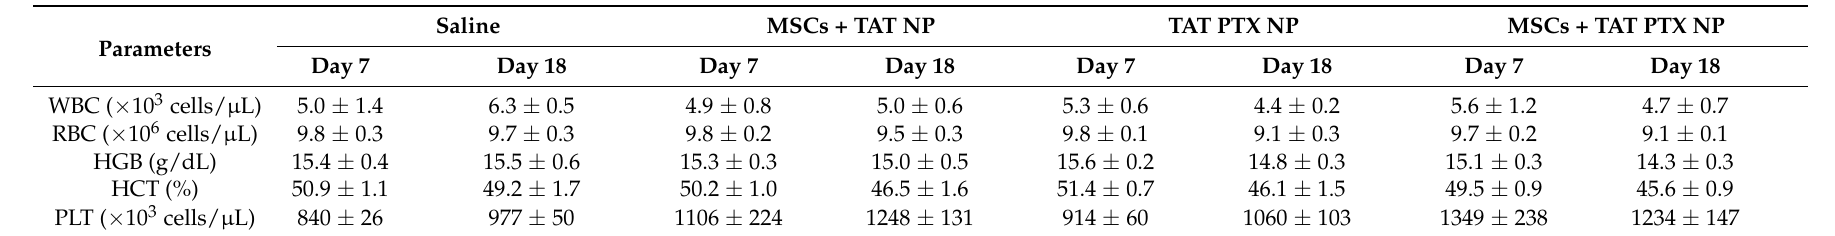
Table 2. Effect of different treatments on complete blood count. Data represents mean ± SD ( n =